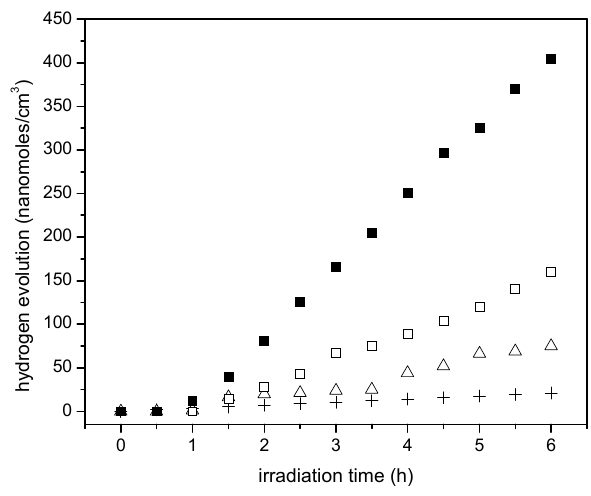
Figure 10. Cumulative hydrogen formation under an argon atmosphere for various photocatalysts using: ( ■ ) Pt–TiO 2 prepared via sol-gel A with 1.70 wt. % of Pt loadings, ( □ ) TiO 2 prepared via sol-gel A and ( Δ ) Degussa P25, (+) Blank run [no photo catalyst loaded]. Photoreaction conditions: pH = 4.00 ± 0.05, 2.00% v / v ethanol, photocatalyst loading: 0.15 g/L. Standard deviation for repeats was ±5%.